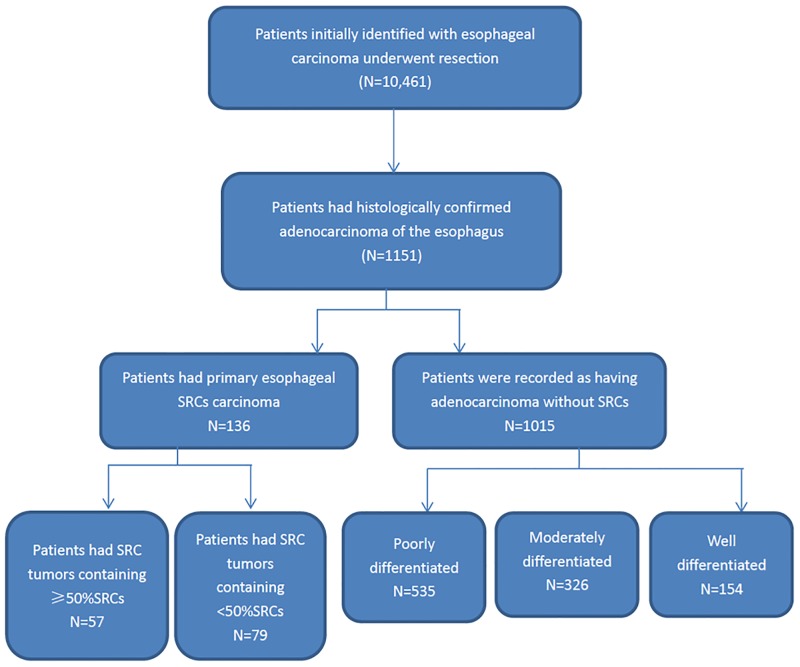
Consort diagram.